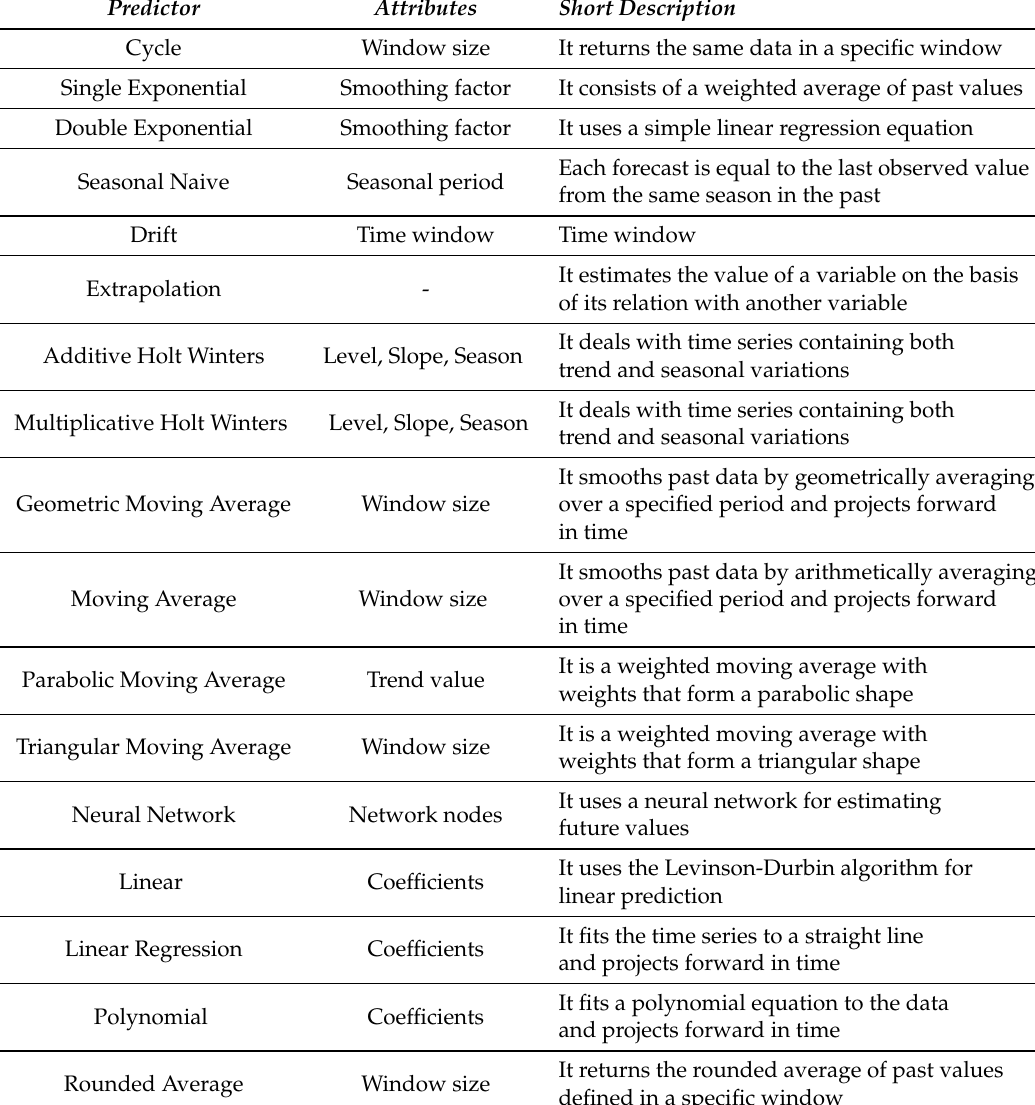
Table 1. Predictors